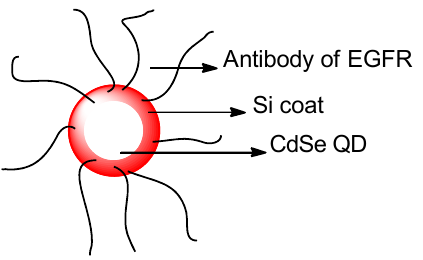
Figure 65. Structure of QD–Ab for targeting tumor cell synthesized by Vibin et al.